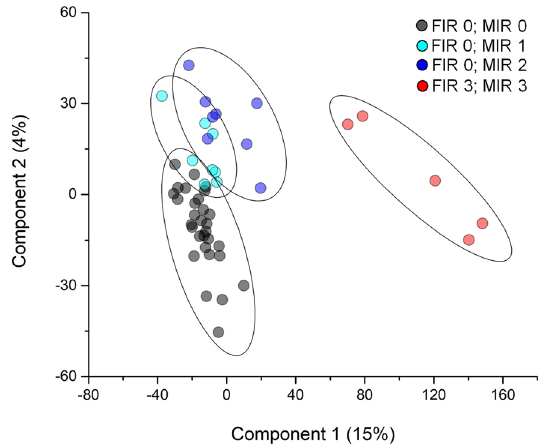
Figure 3. Partial least square discriminant analysis (PLS-DA) of proteins core list. Scatter plot of PLS-DA analysis of FIR 3-MIR 3 (red circles), FIR 0-MIR 2 (blue circles), FIR 0/MIR 1 (cyan circles) and FIR 0/MIR 0 (black circles) samples. Ellipsis indicates 95% confidence interval. Plot shows clustering of two distinct groups (FIR 3 and FIR 0 samples). These proteins can clearly discriminate between the FIR 0 and FIR 3 samples. Besides, a good discrimination between FIR 0-MIR 0 and other FIR 0-MIR 1–2 groups are